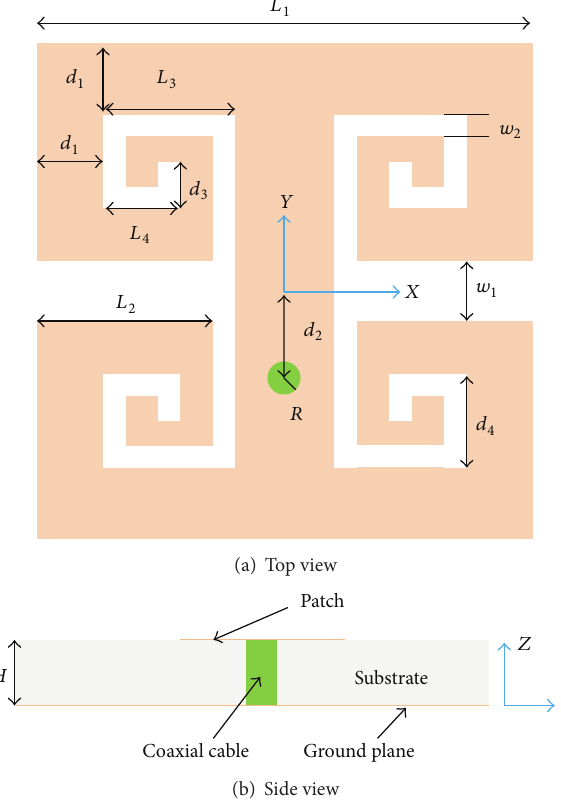
Figure 1: Geometry of the spiral slot patch antenna.